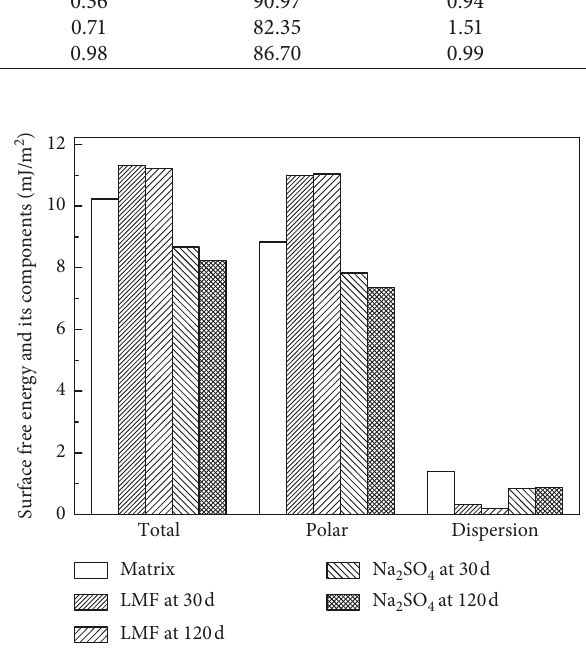
Figure 3: Surface free energy and its components of matrix asphalt and asphalt